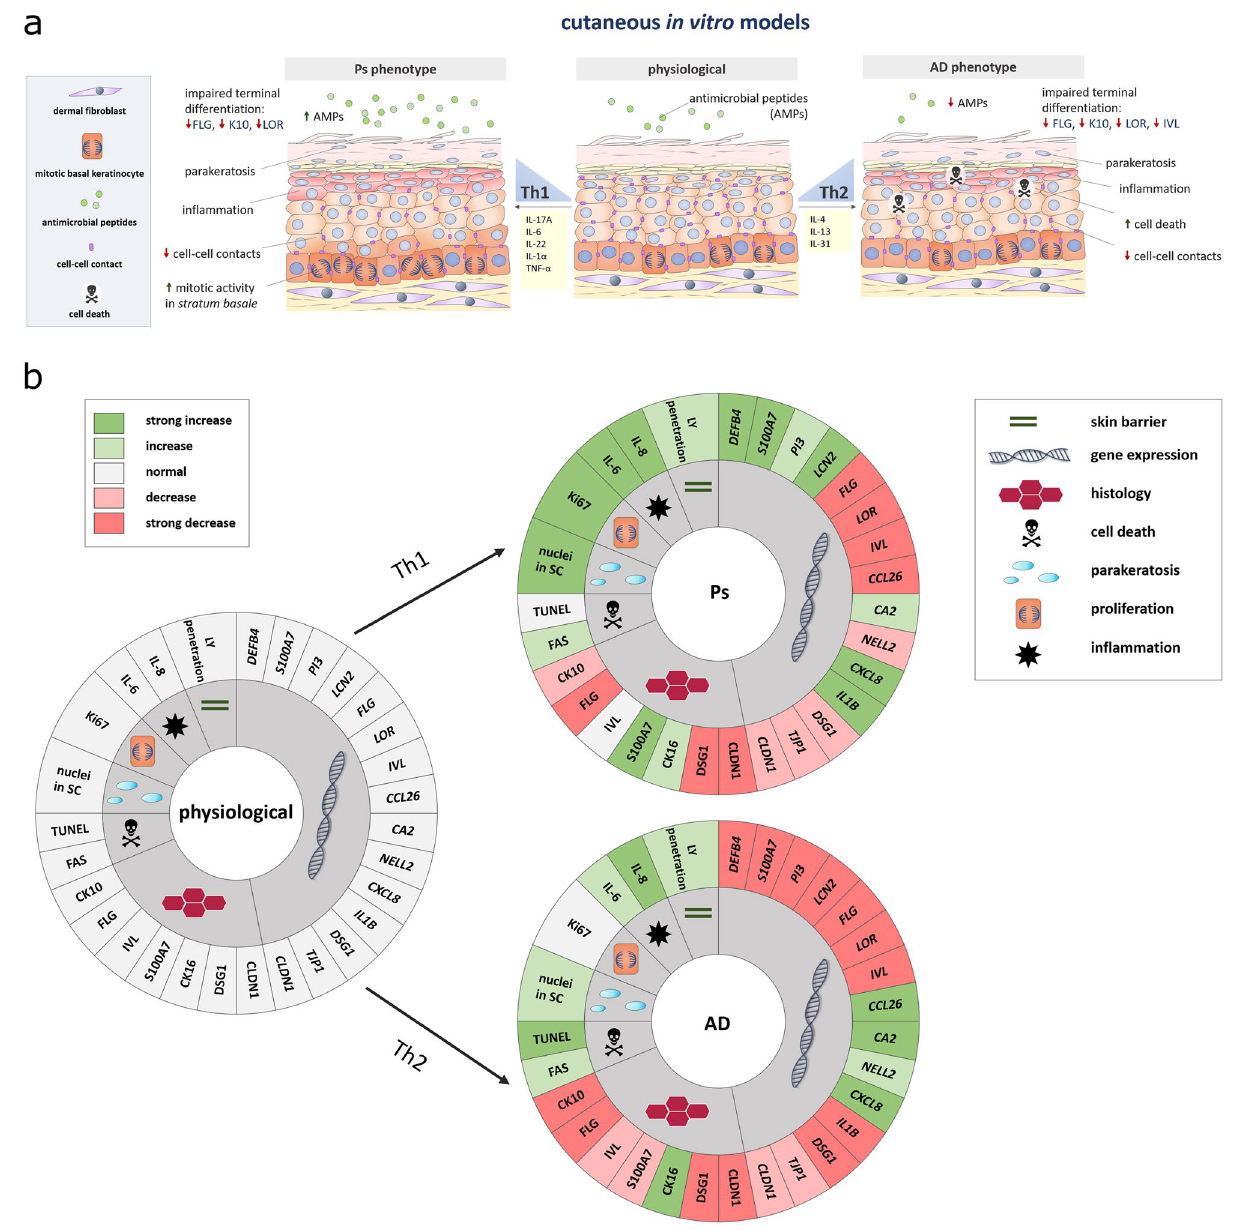
Figure 7. Characterization of Ps- and AD-like skin models ( a ) Graphical summary showing disease-associated attributes of the cutaneous in vitro models mimicing Ps or AD phenotypes. Ps skin models are characterized by differentiation defects, inflammation, impaired cellular attachment, hyperproliferation, parakeratosis and increased AMP production. AD skin models feature differentiation defects, inflammation, diminished cellular attachment, apoptotic events, parakeratosis and decreased AMP formation. ( b ) Color code-based semiquantitative assessment of investigated parameters. Abbrevaitions: SC— stratum corneum , LY—Lucifer Yellow, TUNEL—dT-mediated dUTP nick-end